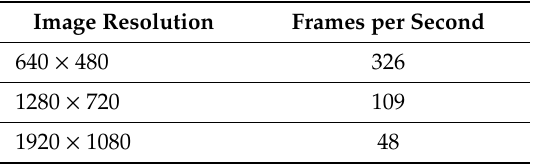
Table 2. Frame rates for di ff erent image sizes at a 100 MHz